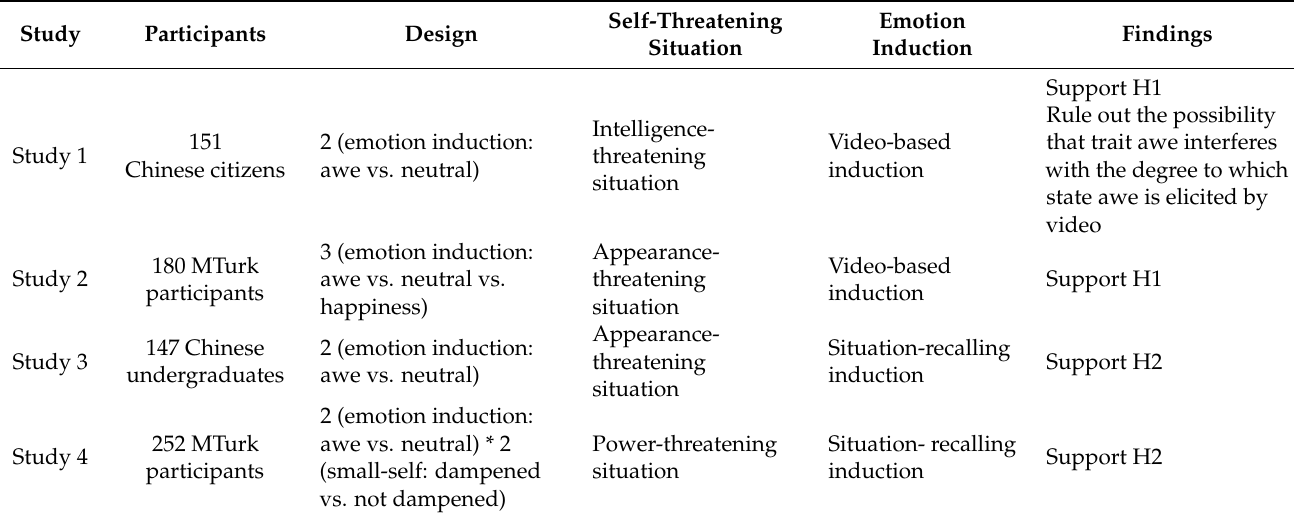
Table 1. Overview of the four